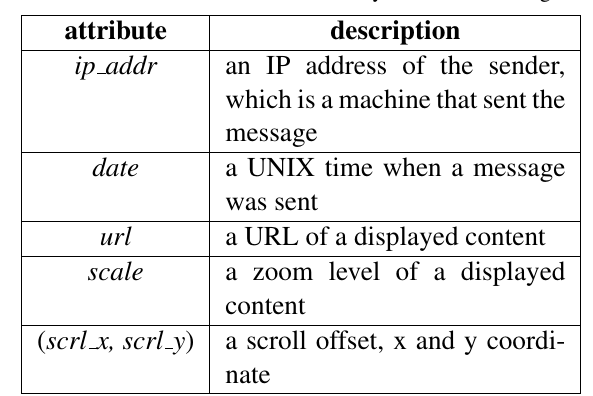
Table 1. Structure of the Positional Synchronous Message